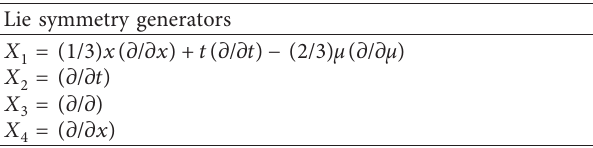
Table 2: Lie symmetry generator of KdV